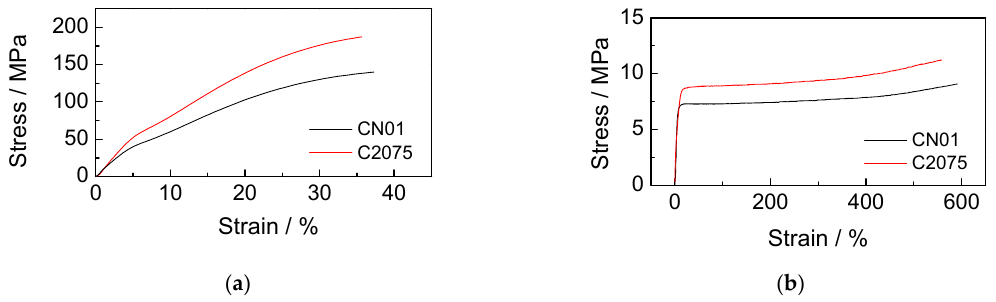
Figure 5. Stress-strain curves of CN01 and C2075 with load ( a ) in the parallel direction to the fibers and